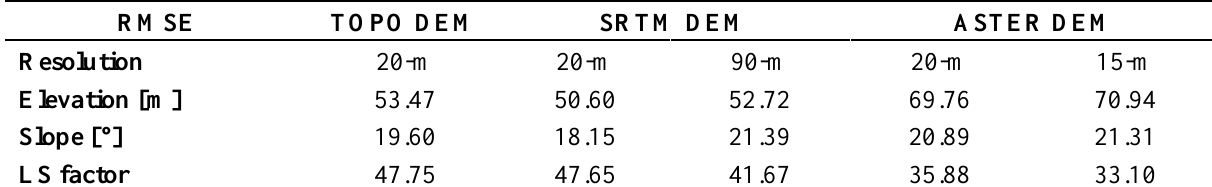
Table 1. Correlation coefficient and root mean square error (RMSE) between DEM and field elevation, slope and LS factor